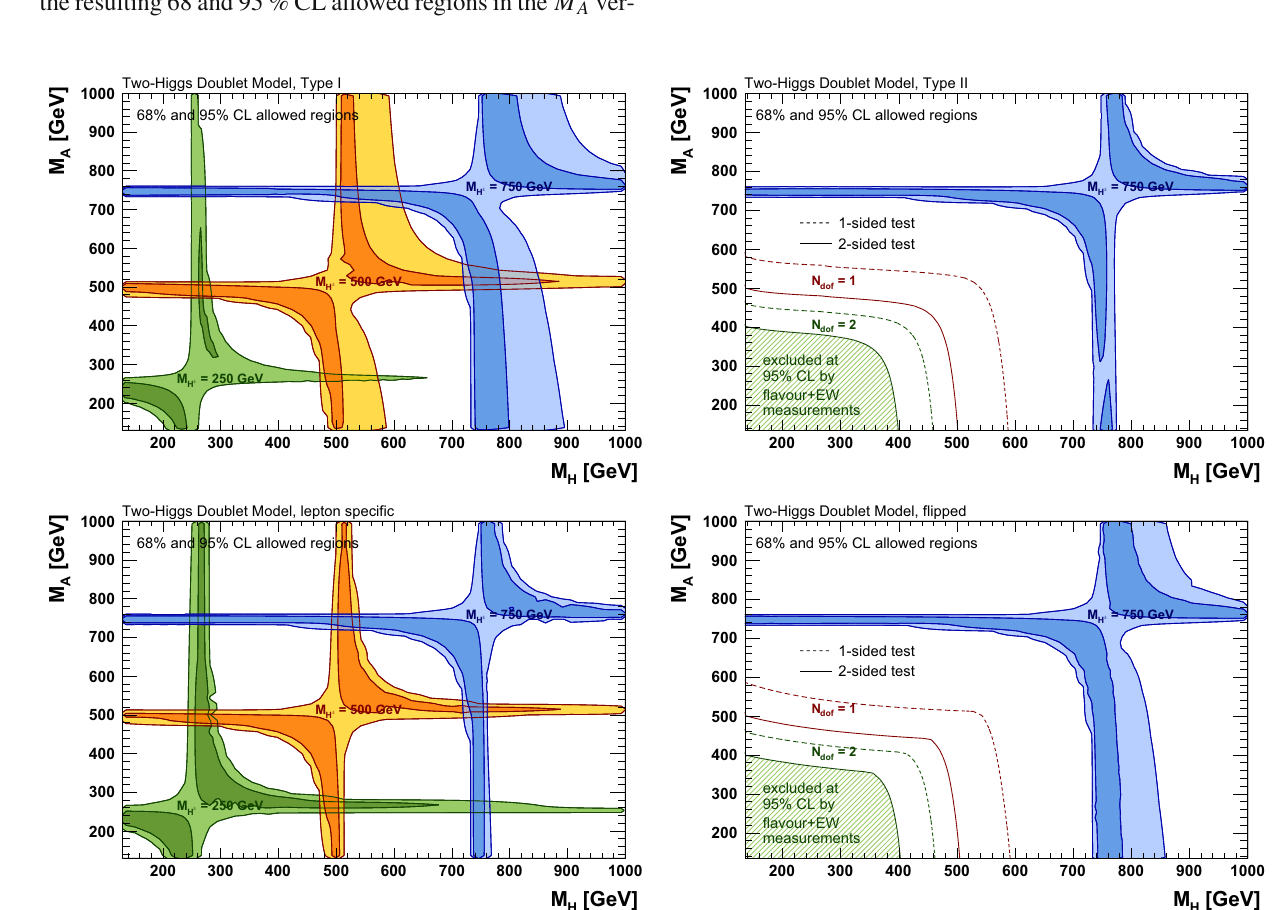
for fixed benchmark values of M H ± and for the four 2HDM scenarios considered:Type-I(topleft),Type-II(topright),leptonspecific(bottom left), and flipped (bottom